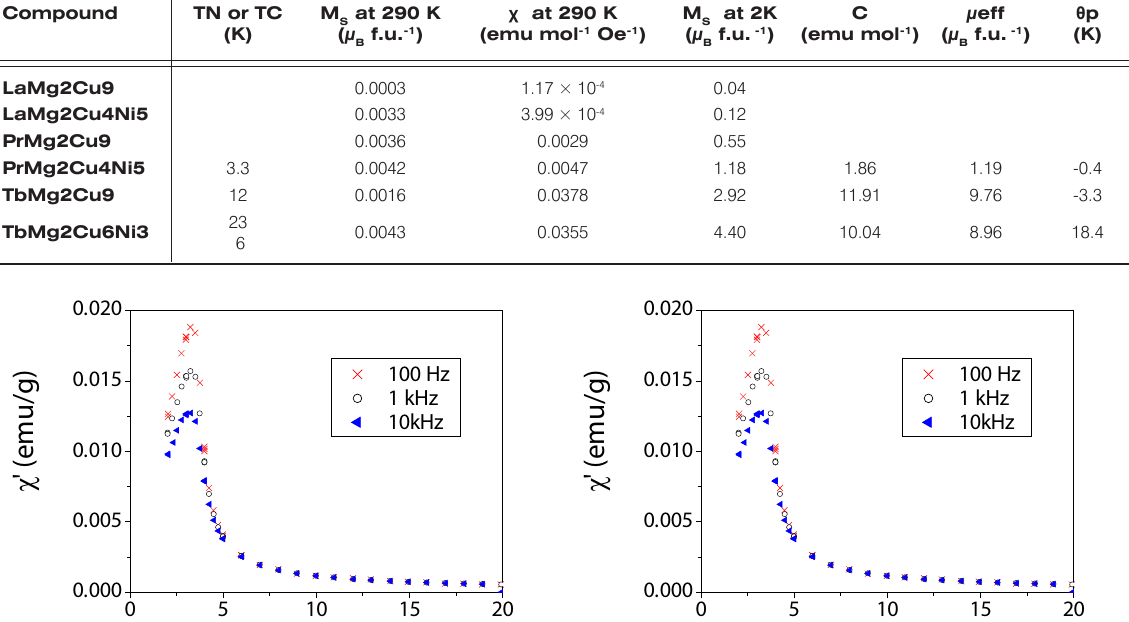
Cu Ni at zero field and different frequencies. 2 4 5